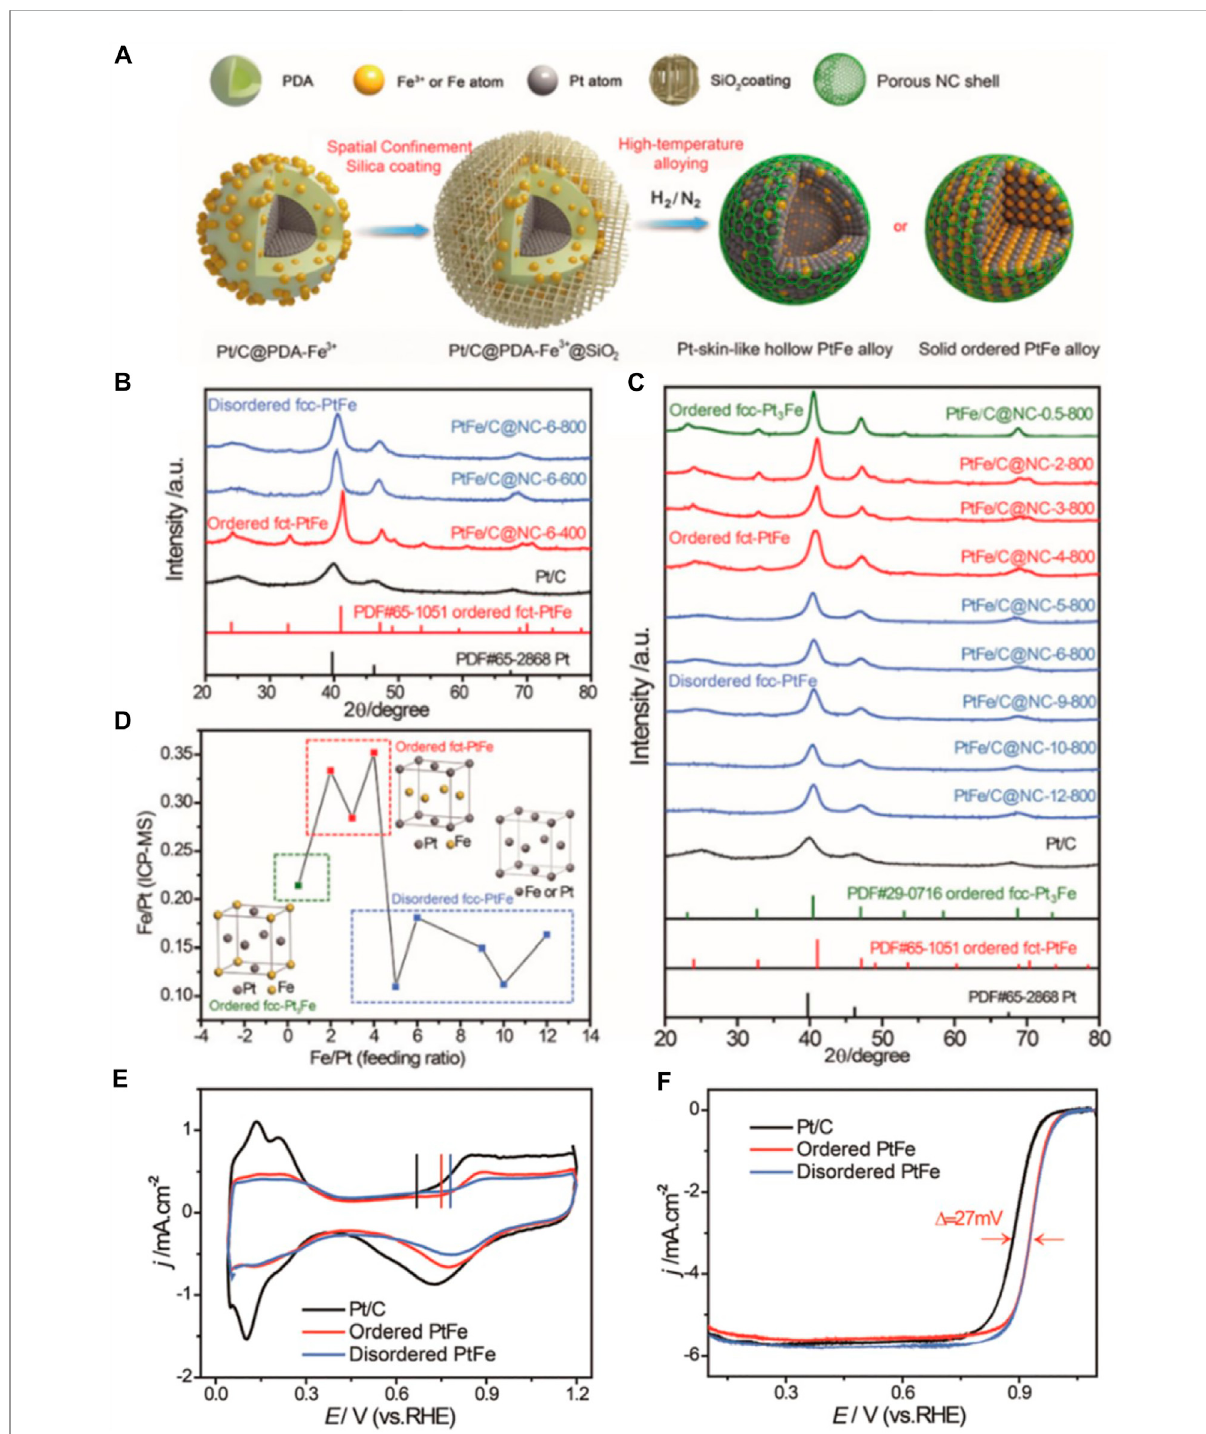
FIGURE 2 (A) Schematic illustration of the thermally driven interfacial diffusion approach. (B) Powder X-ray diffraction patterns of PtFe alloy samples obtained with different annealing temperatures at af fi xed feeding molar ratio of Fe 3+ to Pt and standard PDFs of Pt (PDF card#65-2,868) and intermetallic PtFe (PDF card #65-1,051), for “ PtFe/C@NC-X-T, ” where “ X ” represents the feeding molar ratio of Fe 3+ to Pt and “ T ” represents the annealing temperature. (C) Powder X-ray diffraction patterns of PtFe alloy samples obtained with different feeding molar ratios of Fe 3+ to Pt at 800 ° C and standard PDFs of Pt (PDF card #65-2,868), intermetallic Pt 3 Fe (PDF card #29-0716) and PtFe (PDF card #65-1,051). (D) Relationship betweenthefeedingmolarratioofFe 3+ toPtandthecorrespondingmolarratioofFetoPt,asdeterminedbyICP-MS. (E) CVcurvesoftypicalordered